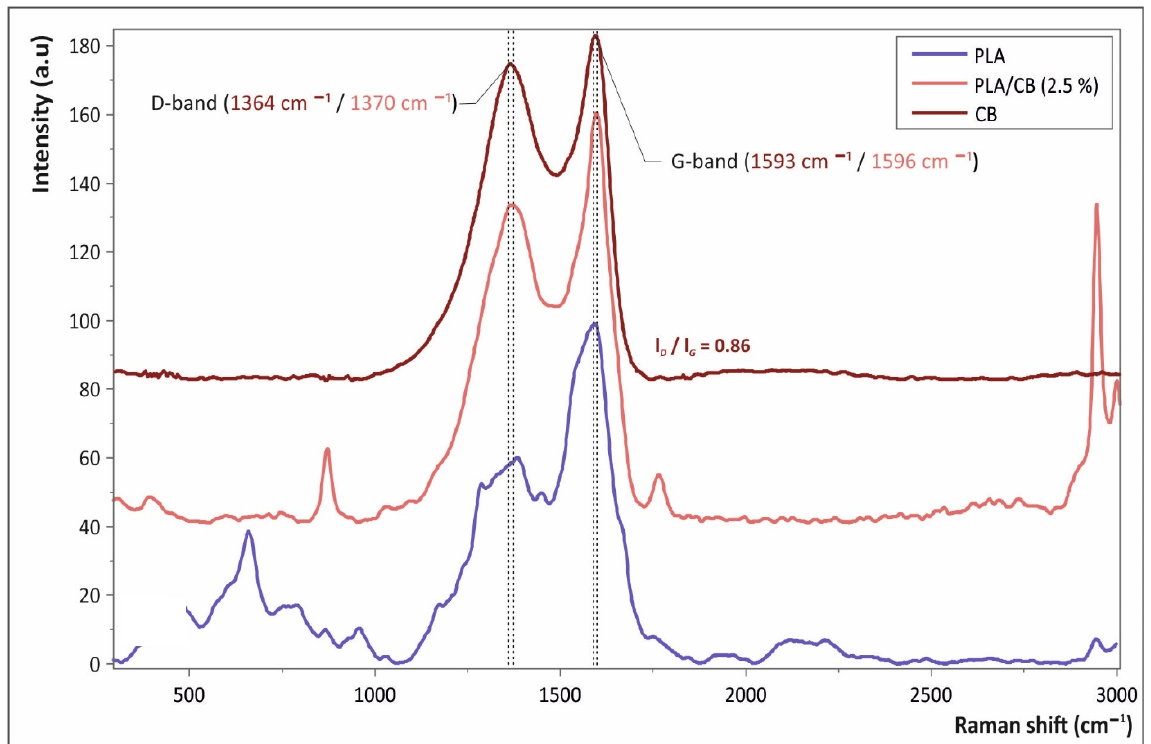
Figure 3. Raman spectra of PLA, CB and PLA/CB nanocomposite (at 2.5 wt.% of filler loading) at the spectral region 300–3300 cm − 1 .